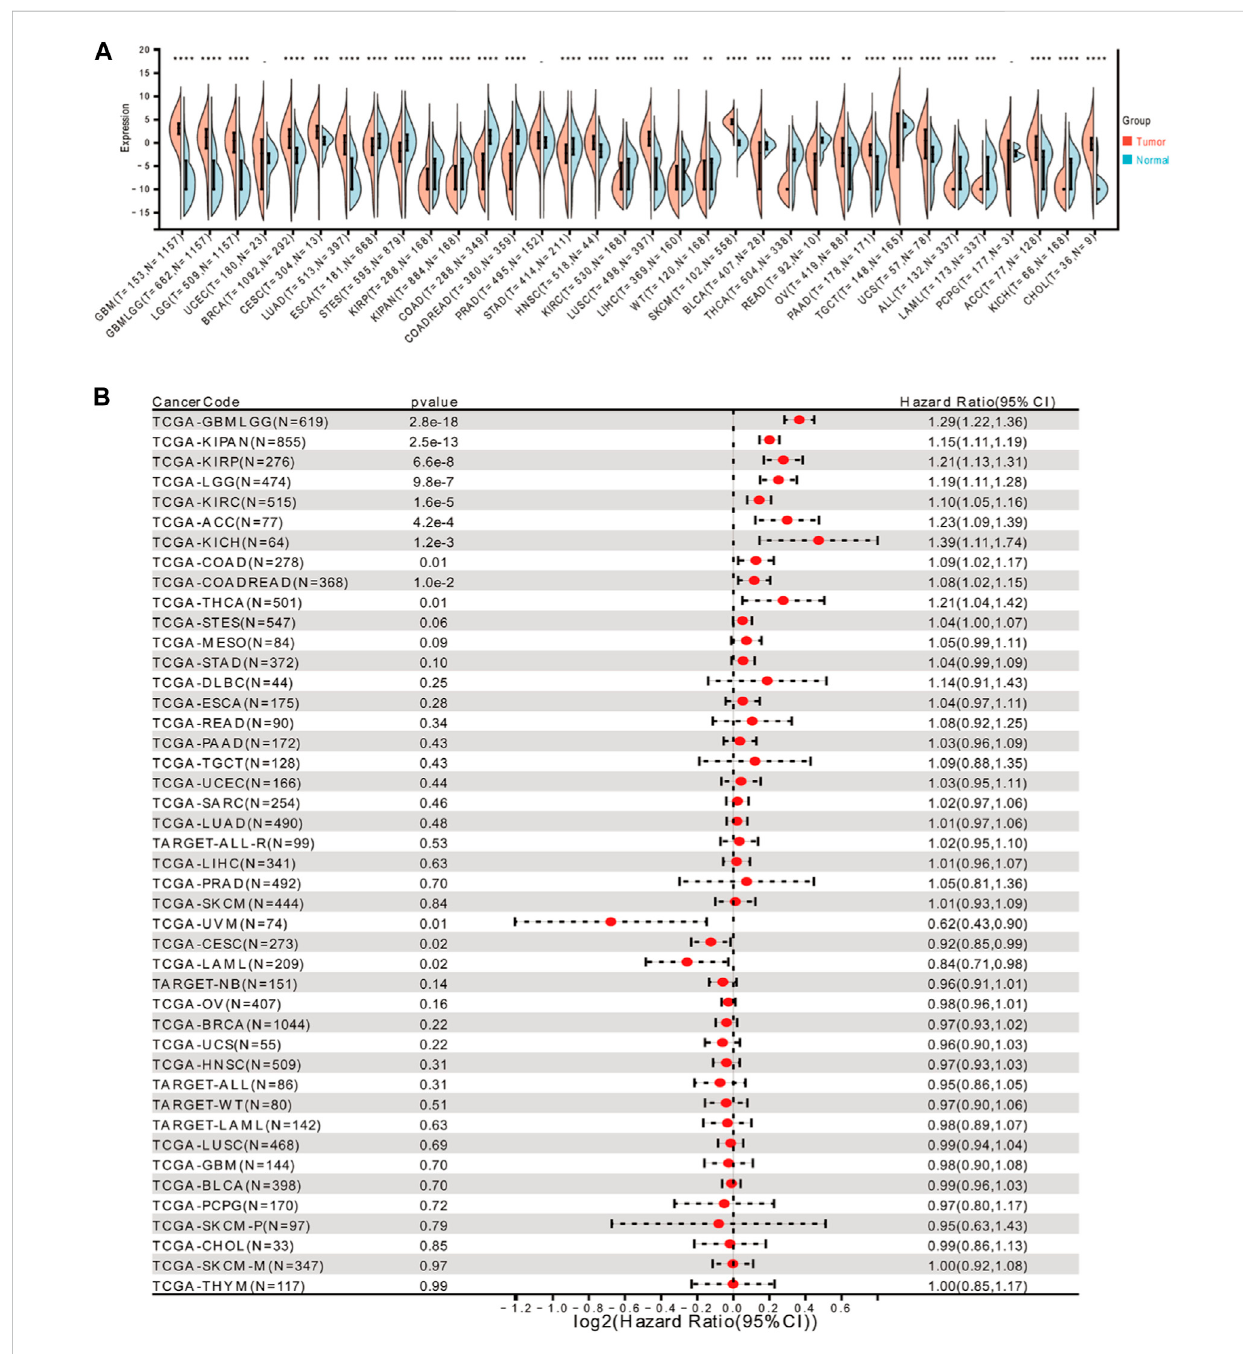
FIGURE 1 Expression of FOXD3-AS1 in pan-cancer and its prognostic signi fi cance. (A) Differential expression of FOXD3-AS1 in pan-cancer patients; (B) Cox analysis of prognostic forest plot of FOXD3-AS1 expression versus survival of TCGA pan-cancer samples. * * * p < 0.01, * * * p < 0.001.